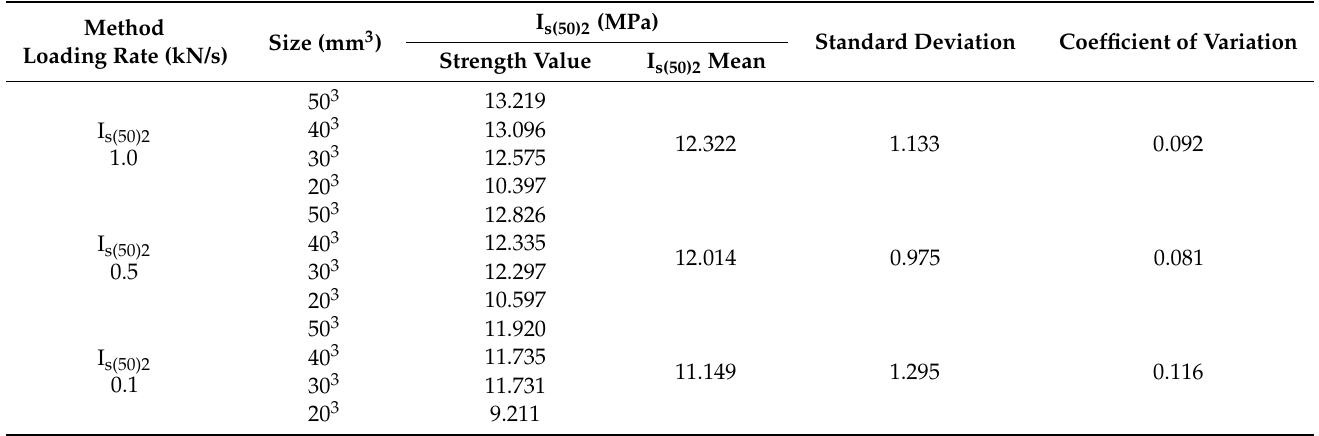
Table 5. Statistical table listing the variability of I s(50)2 for fine-crystalline granite with different sizes and loading rates.